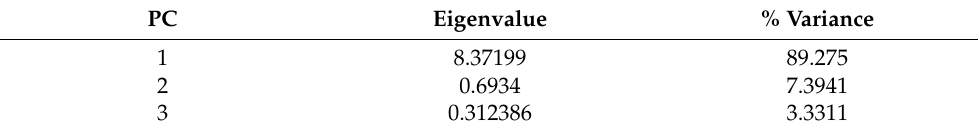
Table 5. PCA of selected species of Causonis